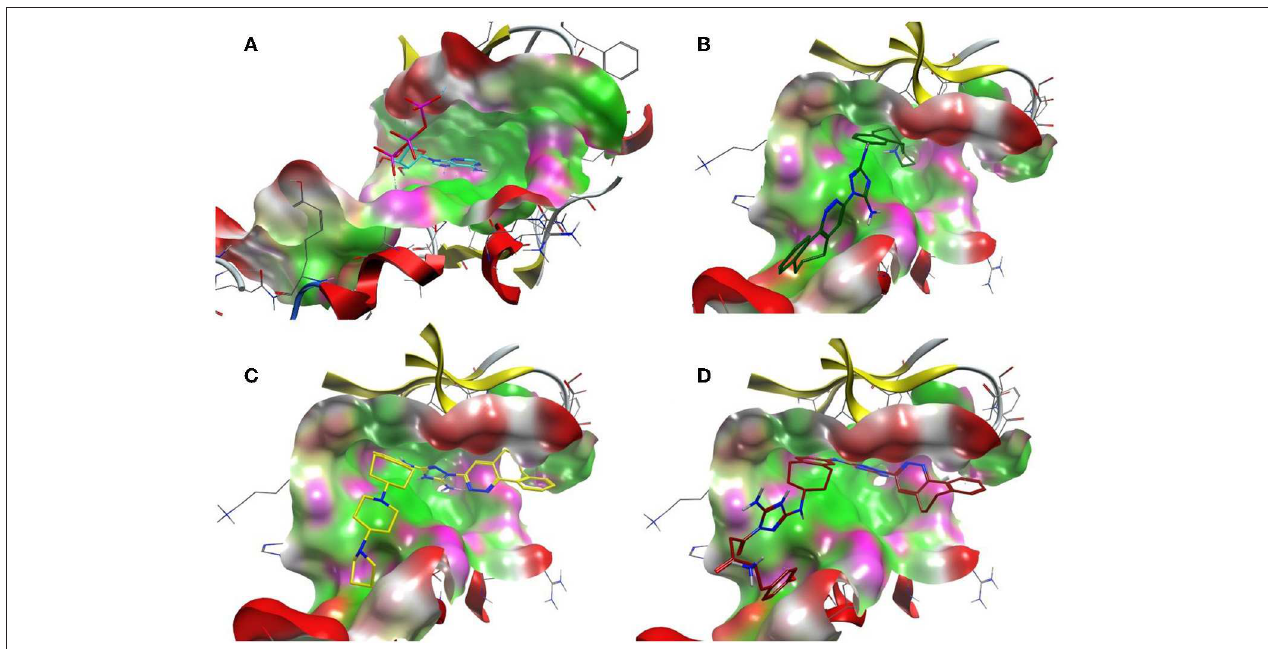
FIGURE 8 | The ATP binding cavity on the surface of the Axl kinase and the drug accommodation inside the pocket. The ATP is shown in cyan (A) , the compound R428 is shown in green (B) , the compound R428_1 is shown in yellow (C) , and our best designed compound R5 is shown in red (D) . The pocket is represented as a surface, the protein chain is represented as a cartoon, the hydrophobic patches of the pocket are shown in light green , the hydrophilic patches are shown in purple , and the hydrogen bond acceptors are shown in red . The compounds in the pocket are represented as a licorice.